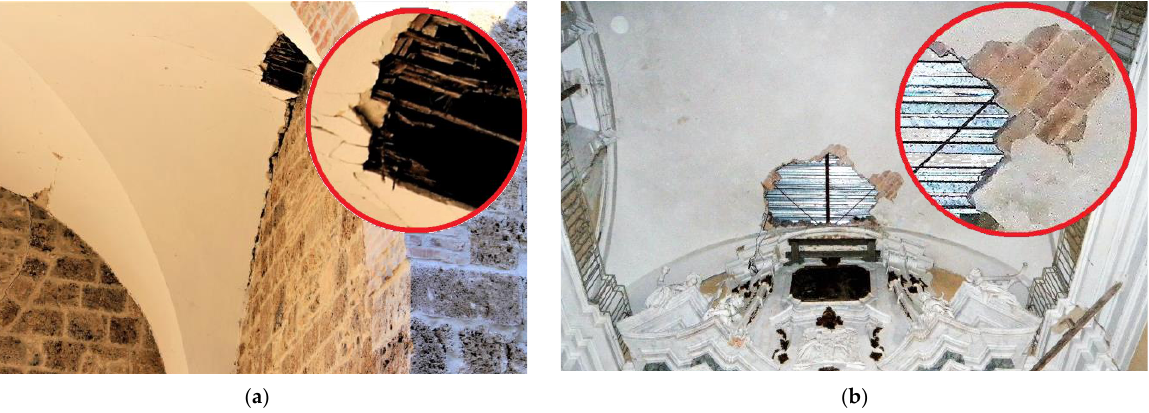
Figure 7. Surveyed domes: ( a ) St. Lowrance in Civitella del Tronto; ( b ) St. Savino in Gualdo, Macerata. The observed crack pattern has been highlighted in red.